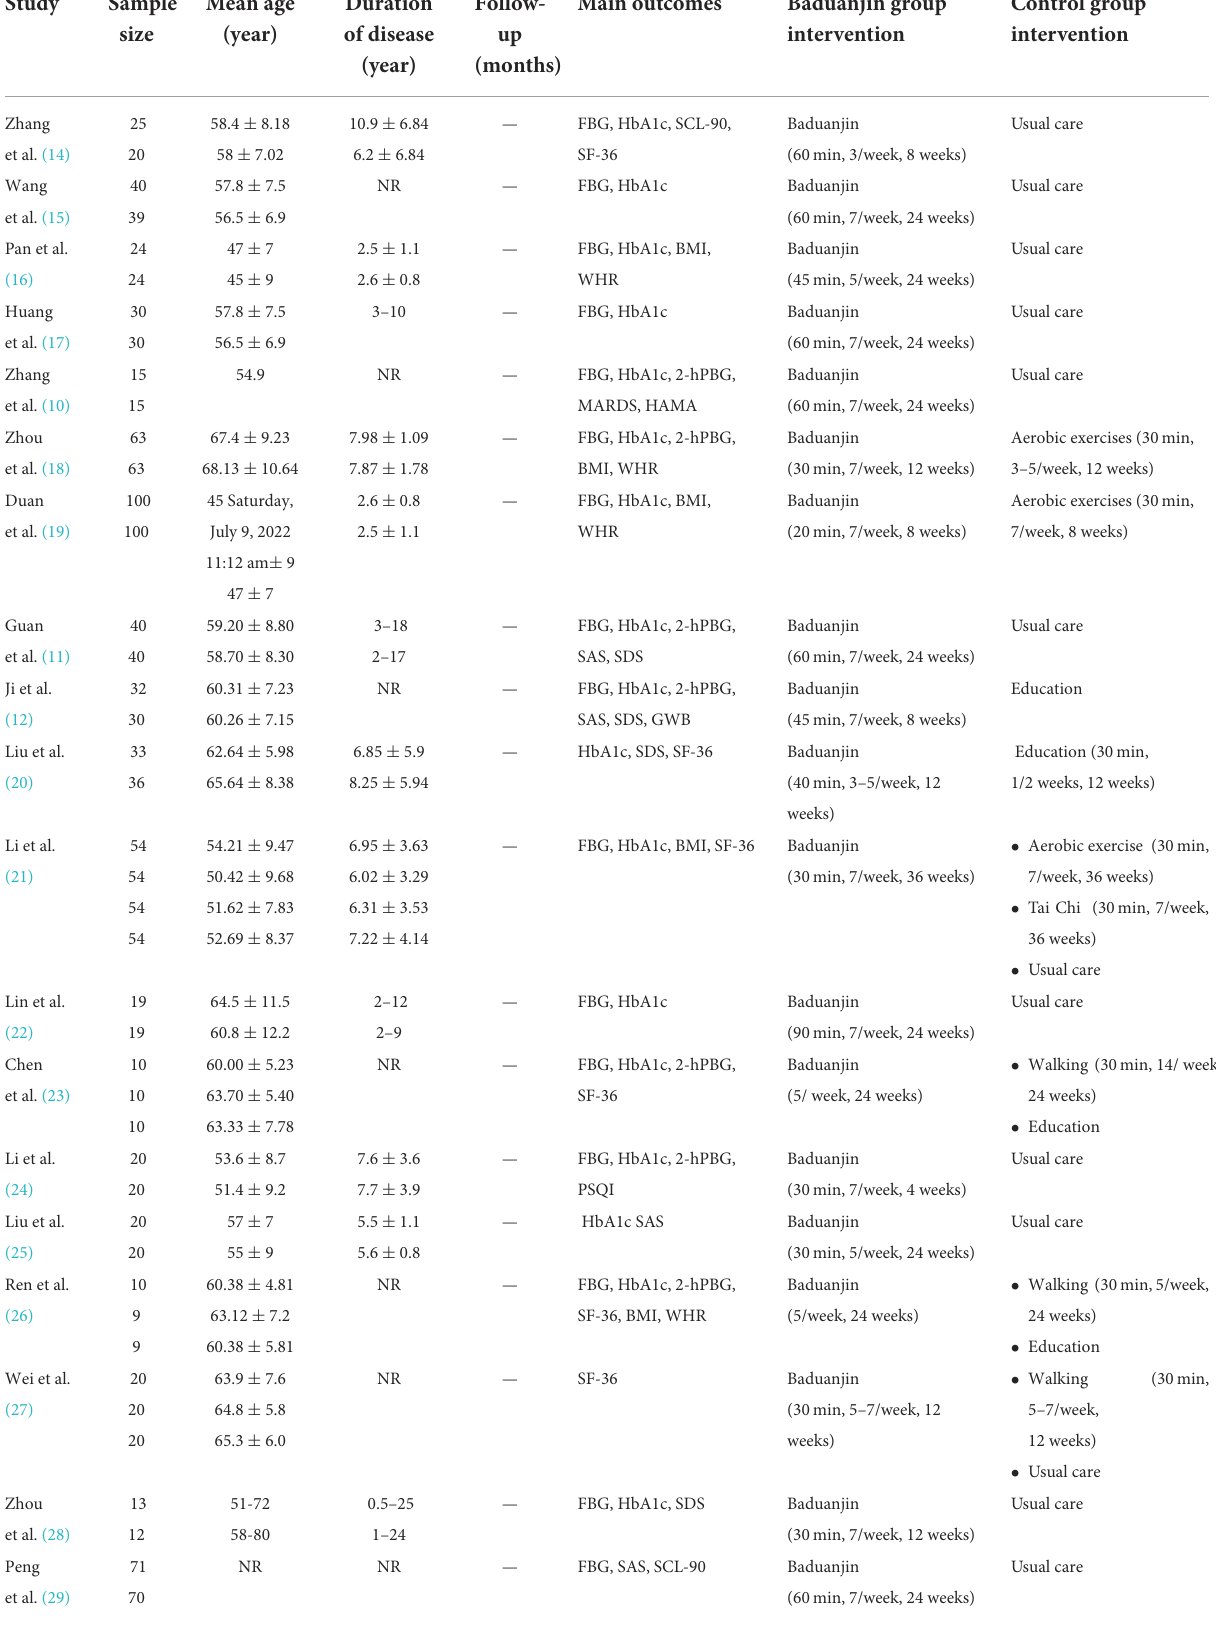
TABLE 1 Randomized controlled trials assessing the effect of Baduanjin exercises for type 2 diabetes.